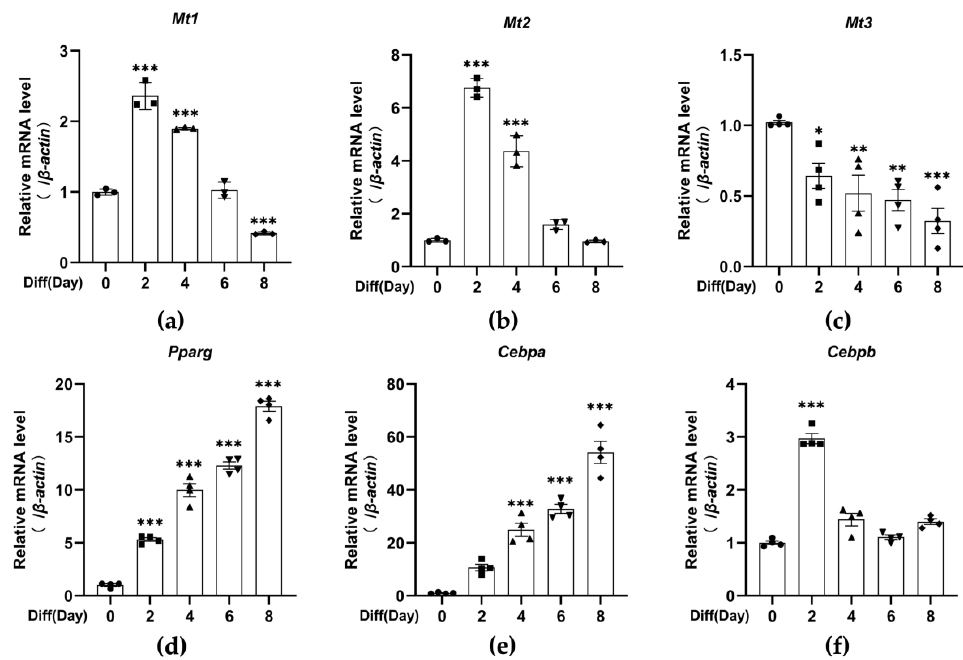
Figure 1. The mRNA levels of Mt3 are significantly decreased during 3T3-L1 adipocyte differentiation. The differentiation of 3T3-L1 adipocytes was induced by the differentiation cocktail. ( a – f ) RT-qPCR analysis was used to detect the mRNA levels of Mt1 , Mt2 , Mt3 , Pparg , Cebpa , and Cebpb at specific times (days 0, 2, 4, 6, and 8). β -actin served as a loading control. The data are presented as the means ± SEM. * p < 0.05, ** p < 0.01, *** p < 0.001 vs. the corresponding control group (day 0) were calculated by one-way ANOVA followed by Dunnett’s Test.